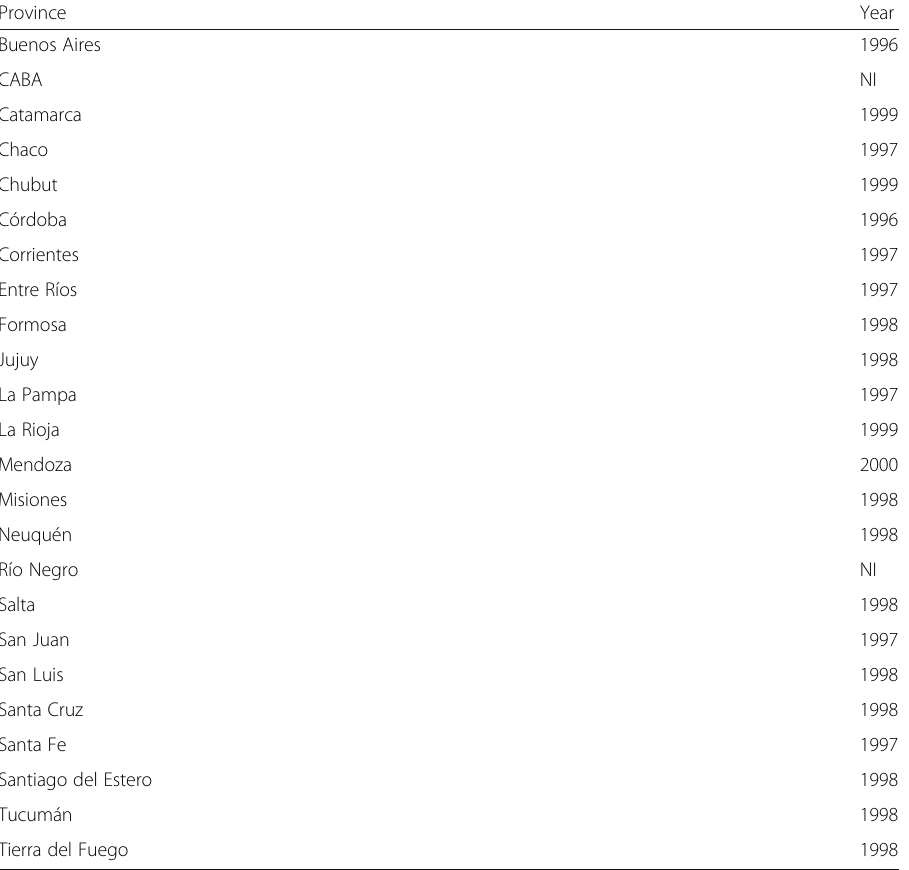
Table 3 Year of implementation of LFE by province